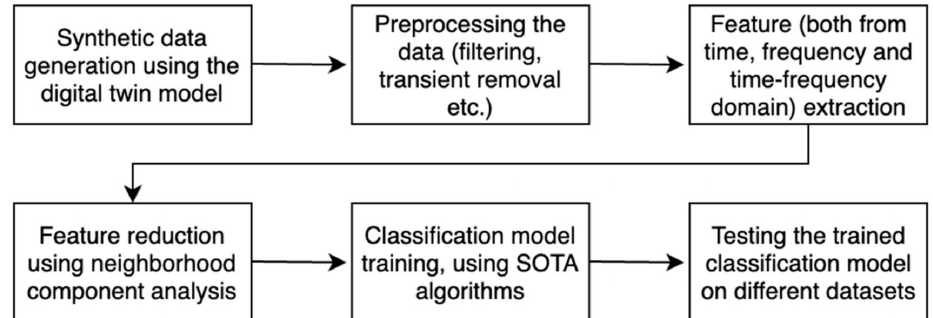
Figure 8. Overall flowchart of the proposed workflow.